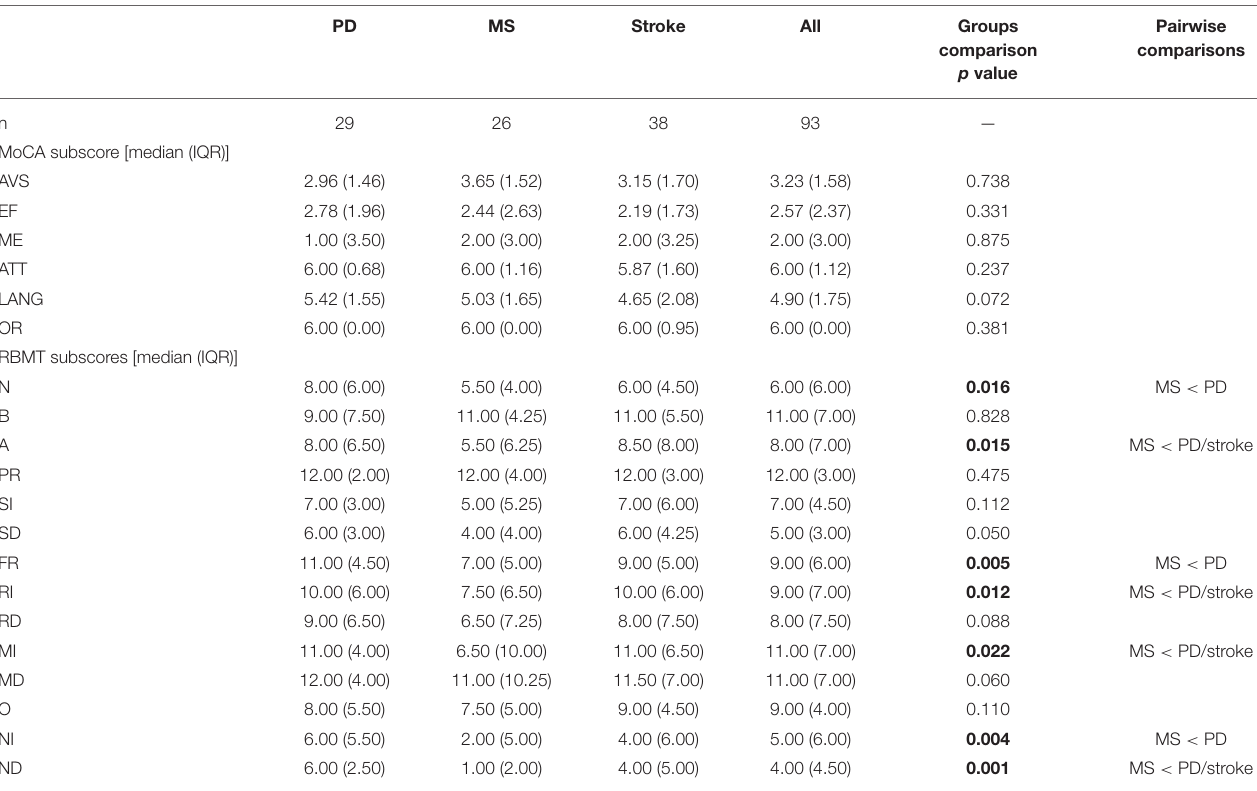
TABLE 2 | Description of sample cognitive profile at baseline. PD MS Stroke All Groups